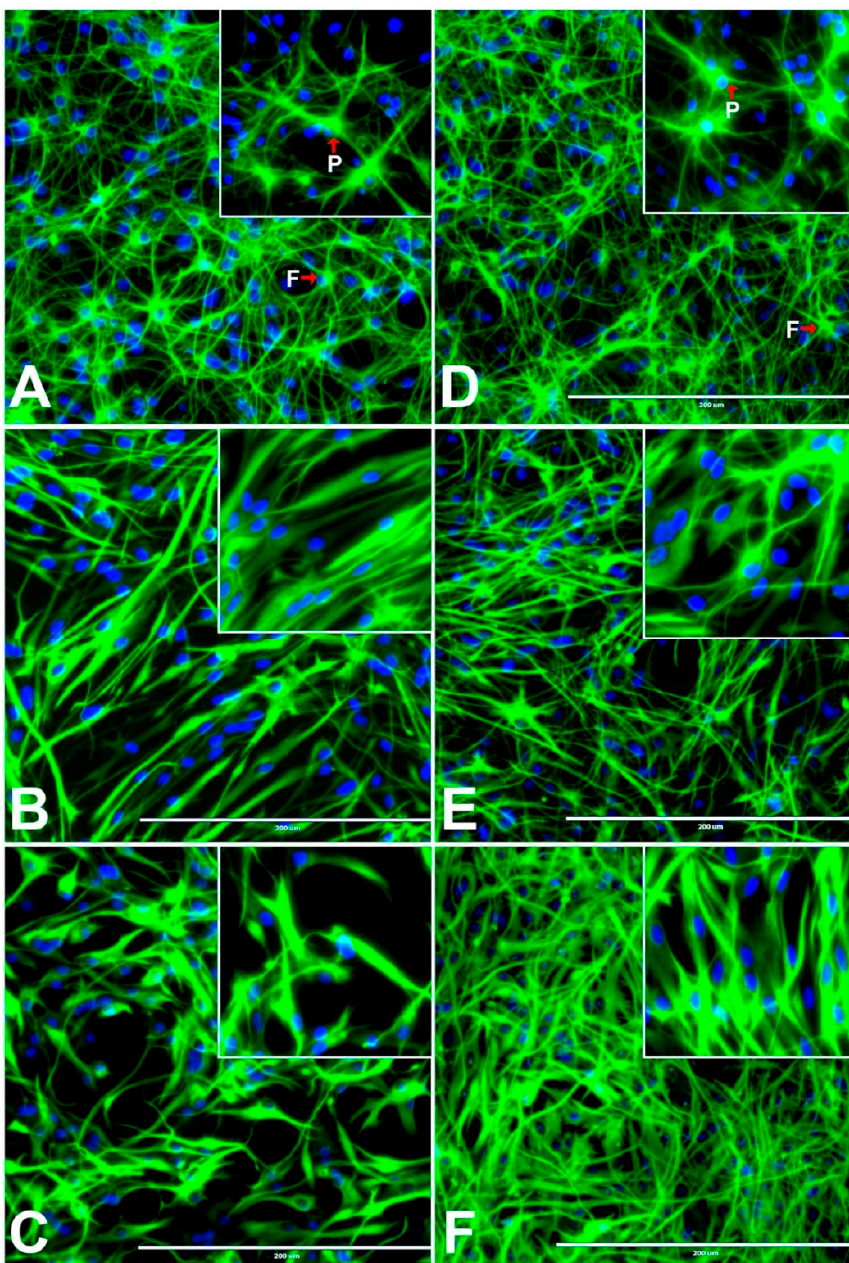
Figure 1. Different concentrations of Bisphenol A (BPA) or Bisphenol F (BPF) affect the morphological differentiation process of rNSCs into astrocytes. The rNSCs grown in astrocyte directed-differentiation media in the presence of or absence of BPA or BPF for a seven day period. Differentiated astrocytes were visualized with astrocyte-specific protein-marker Glial Fibrillary-Acidic-Protein (GFAP) and nuclei fluorescent-marker DAPI. The fluorescent images shown are representative images of astrocyte differentiation ( A ) in the absence of BPA (control), ( B ) in the presence of 50 µ M BPA, ( C ) 100 µ M BPA; ( D ) in the absence of BPF (control), ( E ) in the presence 50 µ M BPF, and ( F ) 100 µ M BPF. Arrows indicate protoplasmic ( small P ) and fibrous ( small F ) astrocytes. Scale bar indicates 200 µ m at 20 ×